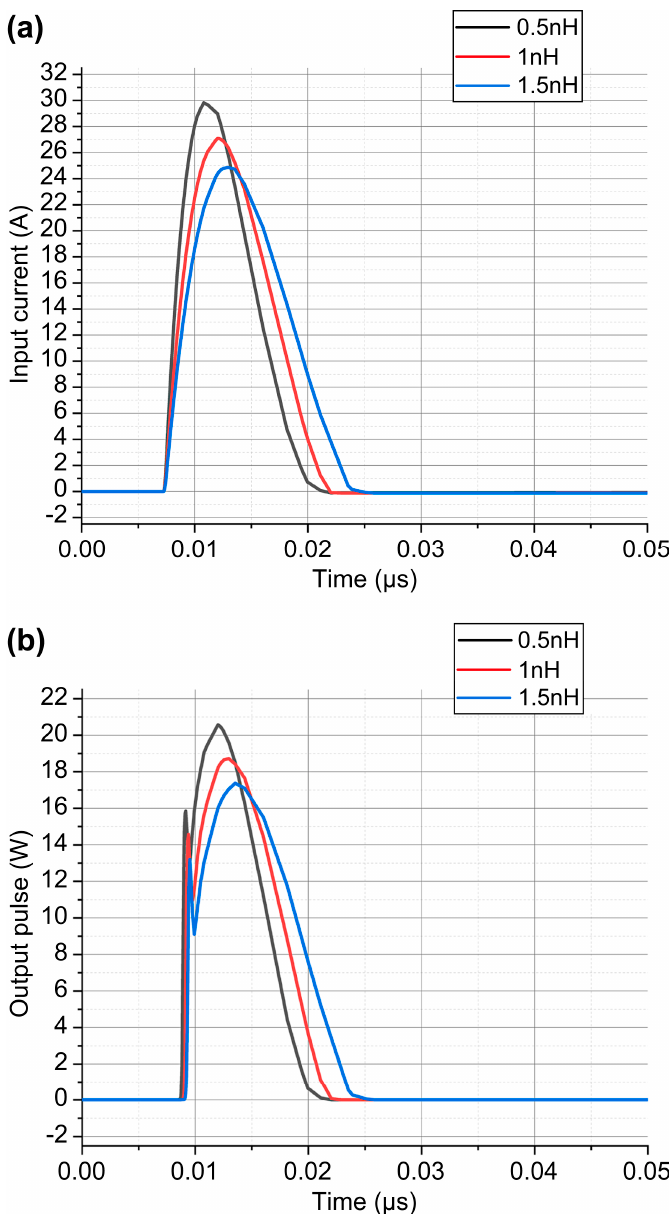
Figure 8. ( a ) Laser − input current and ( b ) output pulse waveforms for different package parasitic inductances.